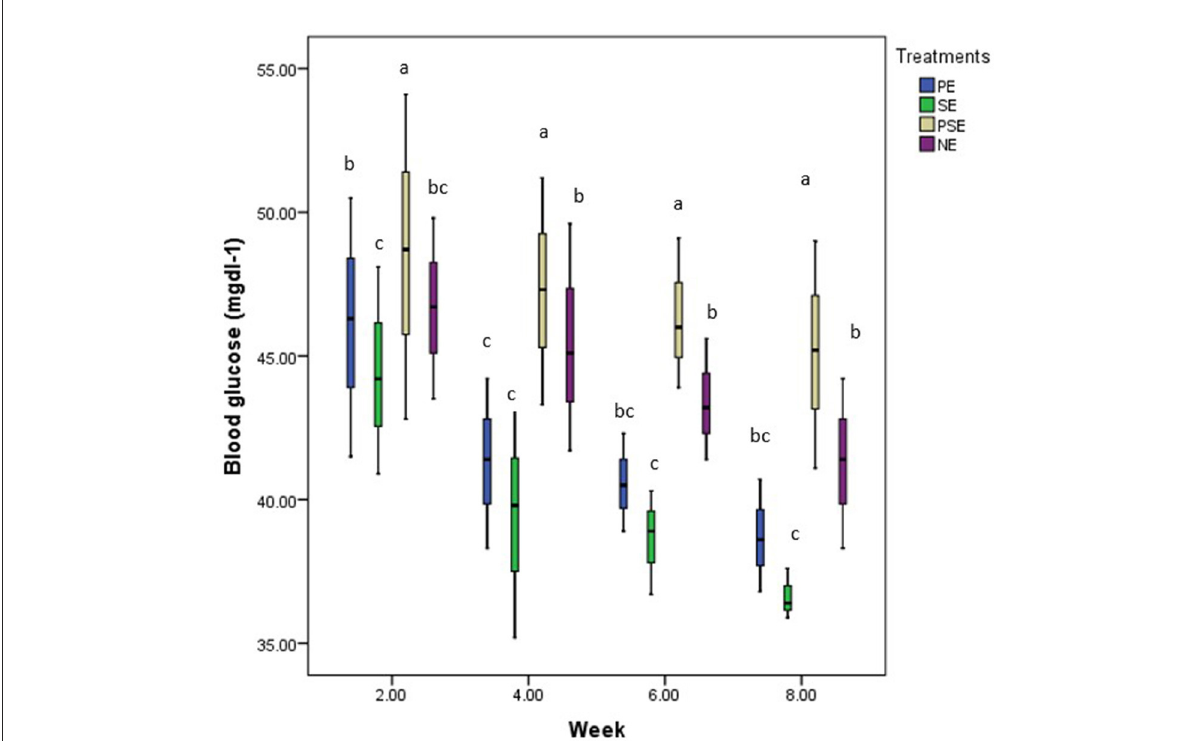
FIGURE7 A boxplot showing the mean weekly glucose (mg/dl) values and bi-weekly trend of glucose in blood samples of C. gariepinus exposed to plant enriched (PE), substrates enriched (SE), plant and substrates enriched (PSE) and non-enriched (NE) culture tanks throughout the study period. abcd Mean values with different superscripts were significantly ( p < 0.05) different between